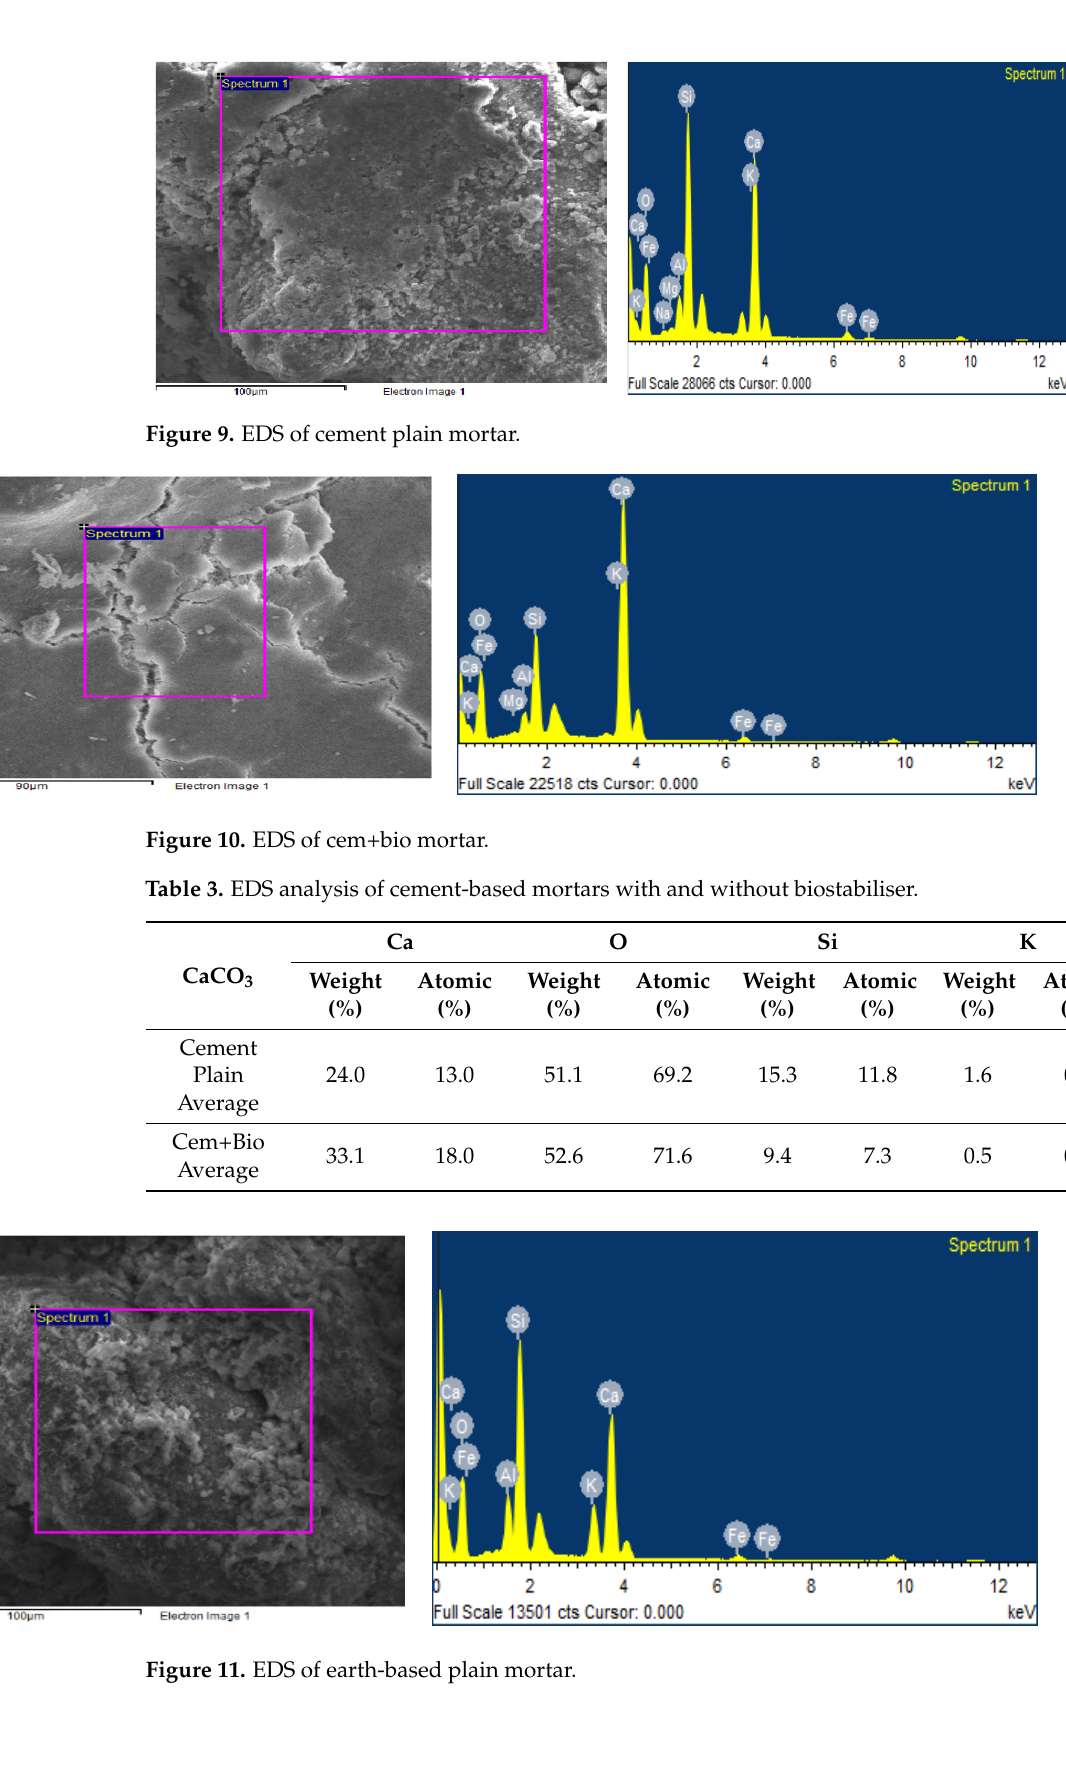
Figure 11. EDS of earth-based plain mortar.